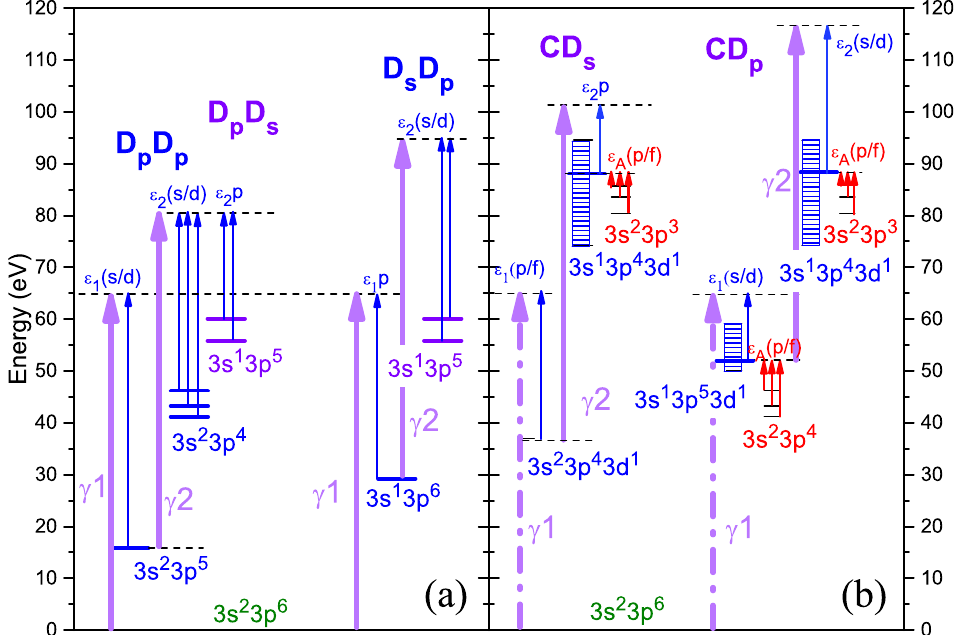
Figure 1. Energy scheme of the sequential two-photon double ionization of argon. ( a ) Direct one-electron ionization at each step. ( b ) Correlational processes relevant to the first ionization step. Designations: bold violet arrows—energies of the exciting photons: solid arrows—direct ( D ) photoionization processes and dash-dotted arrows—correlational ( C ) processes in the photoionization. Thin arrows—kinetic energy of the emitted photoelectrons (blue) and Auger electrons (red). Vertical rectangles represent a set of energy levels of the proper configuration allowed according to the selection rules. Energy levels were computed in the HF approach with DPES. The heights of the rectangles were estimated using the “transition array” technique